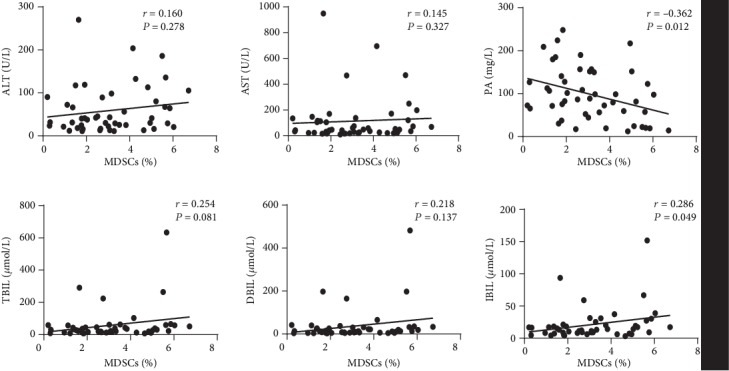
Correlation between the percentages of circulating MDSCs and levels of liver function parameters. Liver function parameters including alanine aminotransferase (ALT), aspartate aminotransferase (AST), prealbumin (PA), total bilirubin (TBIL), direct bilirubin (DBIL), and indirect bilirubin (IBIL).